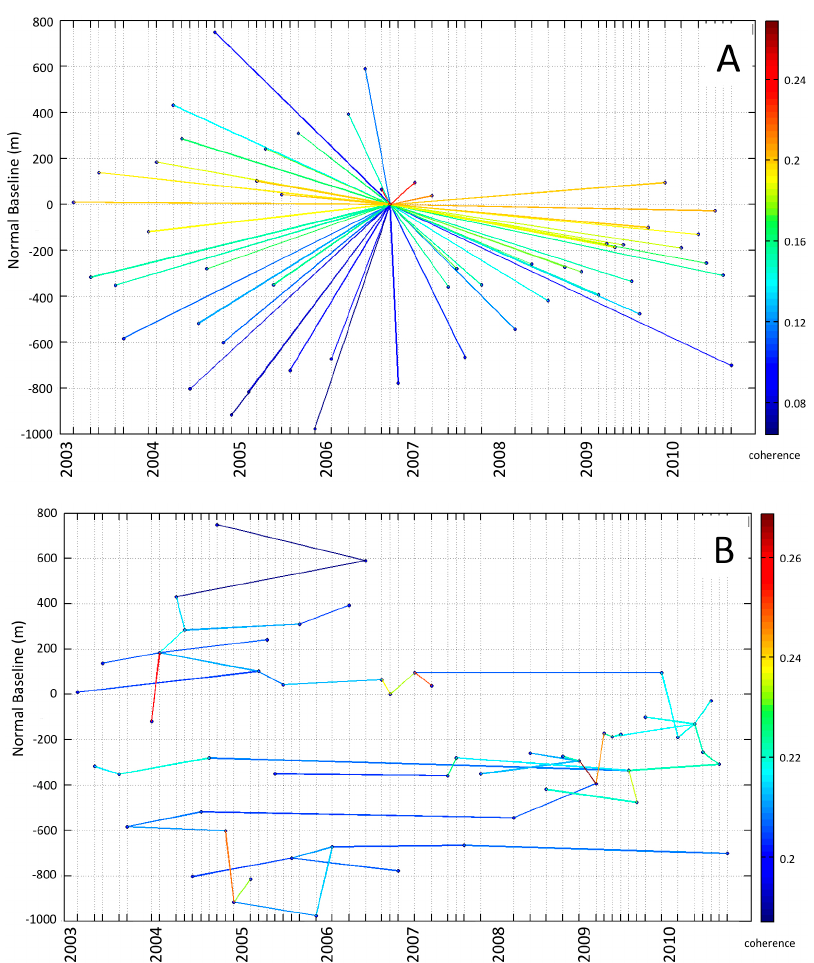
Figure 4. Graphs used to connect images relating to temporal baseline ( X axis) and normal baseline ( Y axis). Every dot represents an image, while every line represents an interferogram. Colors from blue to red show increasing value of spatial coherence. It is worth noticing different values of spatial coherence achievable from: “star” graph ( A ); and Minimum Spanning Tree (MST) graph ( B ). In particular, minimum values are considerable higher for MST graph. The example refers to the Envisat descending dataset.